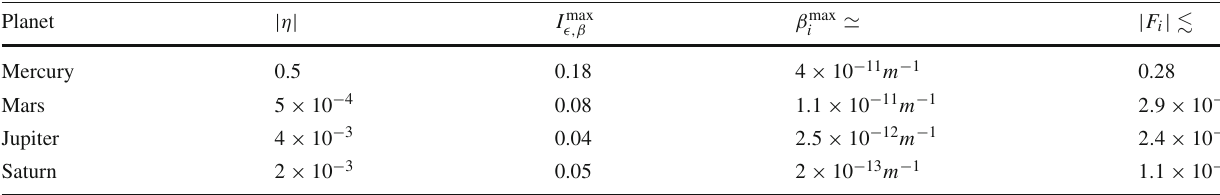
Table 3 Bounds on F i , i = ± , Y obtained from (33) using the values of periastron advance for planets of the Solar